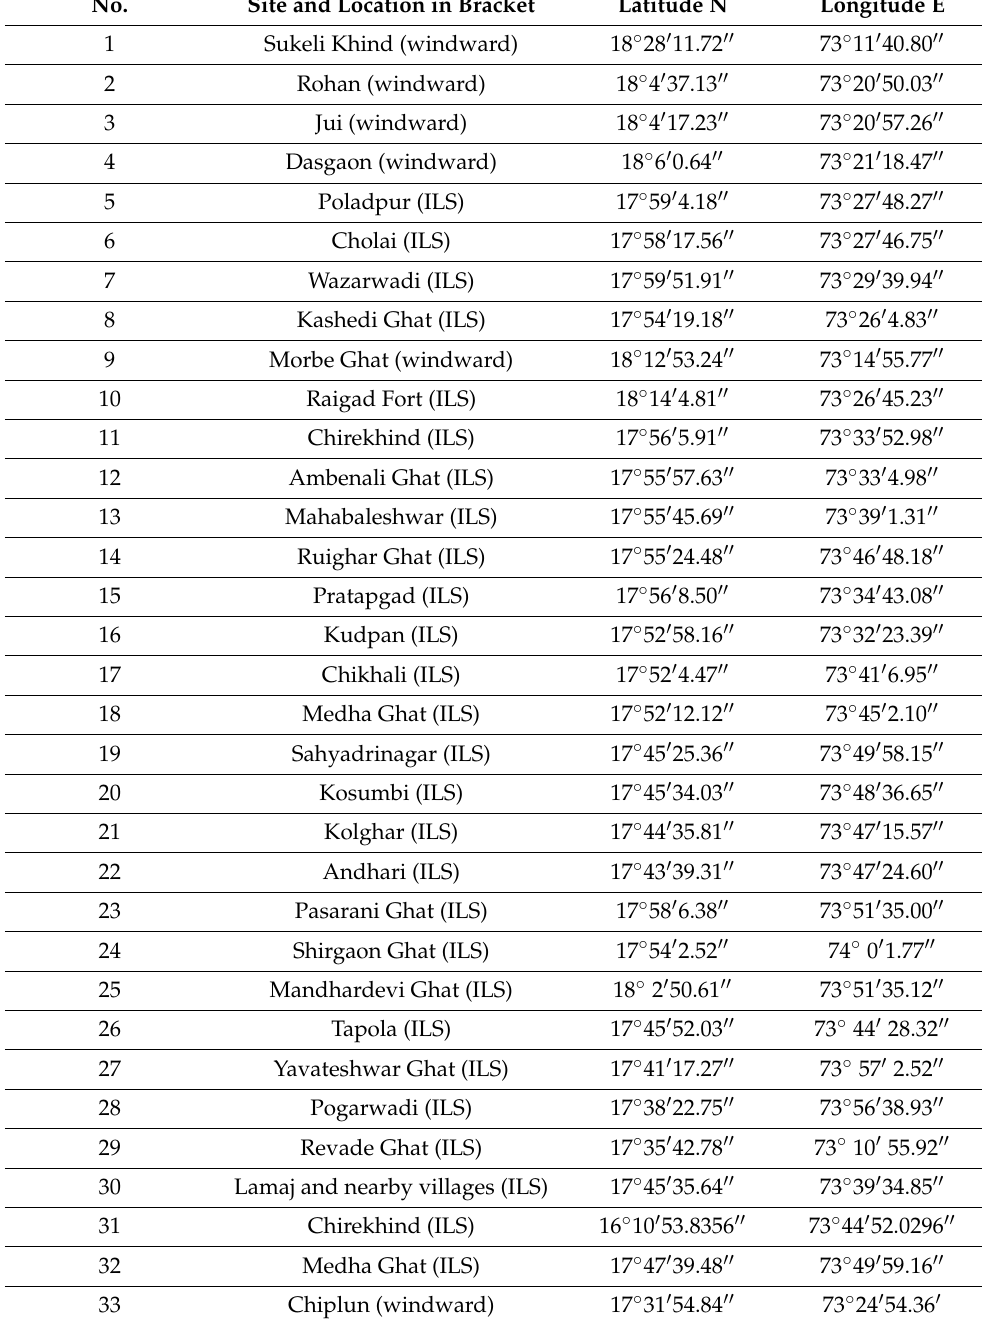
Table 4. Locations of LS-prone sites in the Raigad-Satara region. The words windward, ILS and DLS indicate the locations of LS sites on the windward, immediate leeward and distant leeward sites, of the WG mountains,